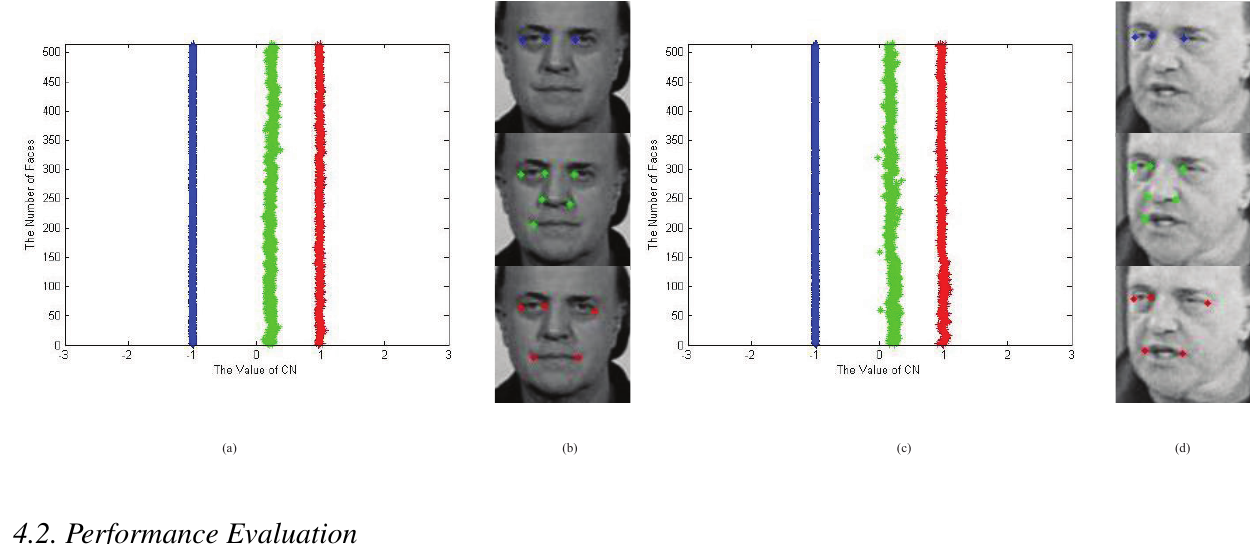
Figure 8. CN values for subsets with three (blue), five (red) and six (green) points: ( a ) histograms of CN values on the subsets of fiducial points whose locations are annotated in the frontal face images in ( b ), and ( c ) histograms of CN values on the same combinations of points as (a). The point coordinates for (c) are extracted from images in ( d ), significantly different from (b). Horizontal axes of the histograms are CN values, and the vertical axes are the number of